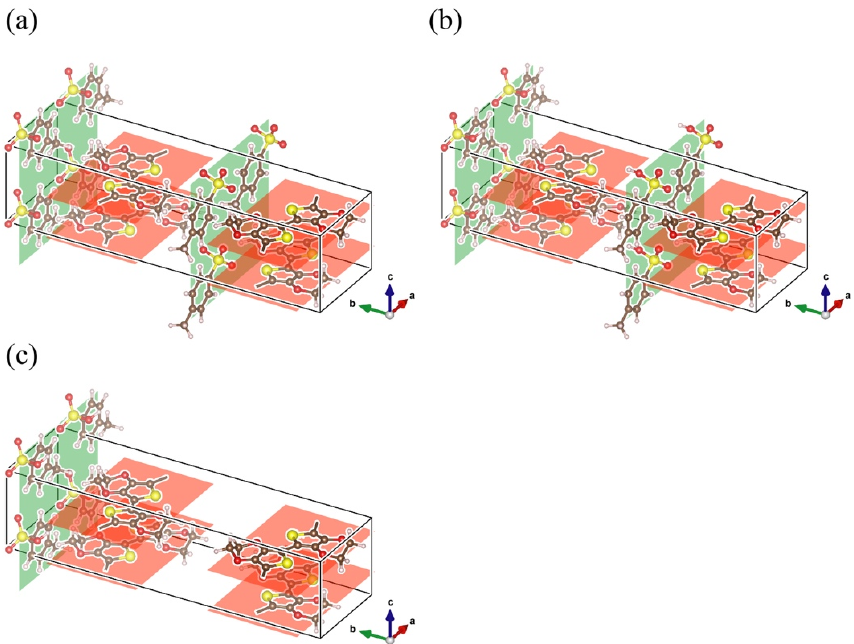
Figure 1. Calculation models of ( a ) PEDOT:Tos, ( b ) highly doped PEDOT:PTSA, and ( c ) poorly doped PEDOT: PTSA. The red, yellow, dark brown, and gray spheres indicate the atoms of oxygen, sulfur, carbon, and hydrogen. The red and green areas indicate PEDOT and dopant layer.